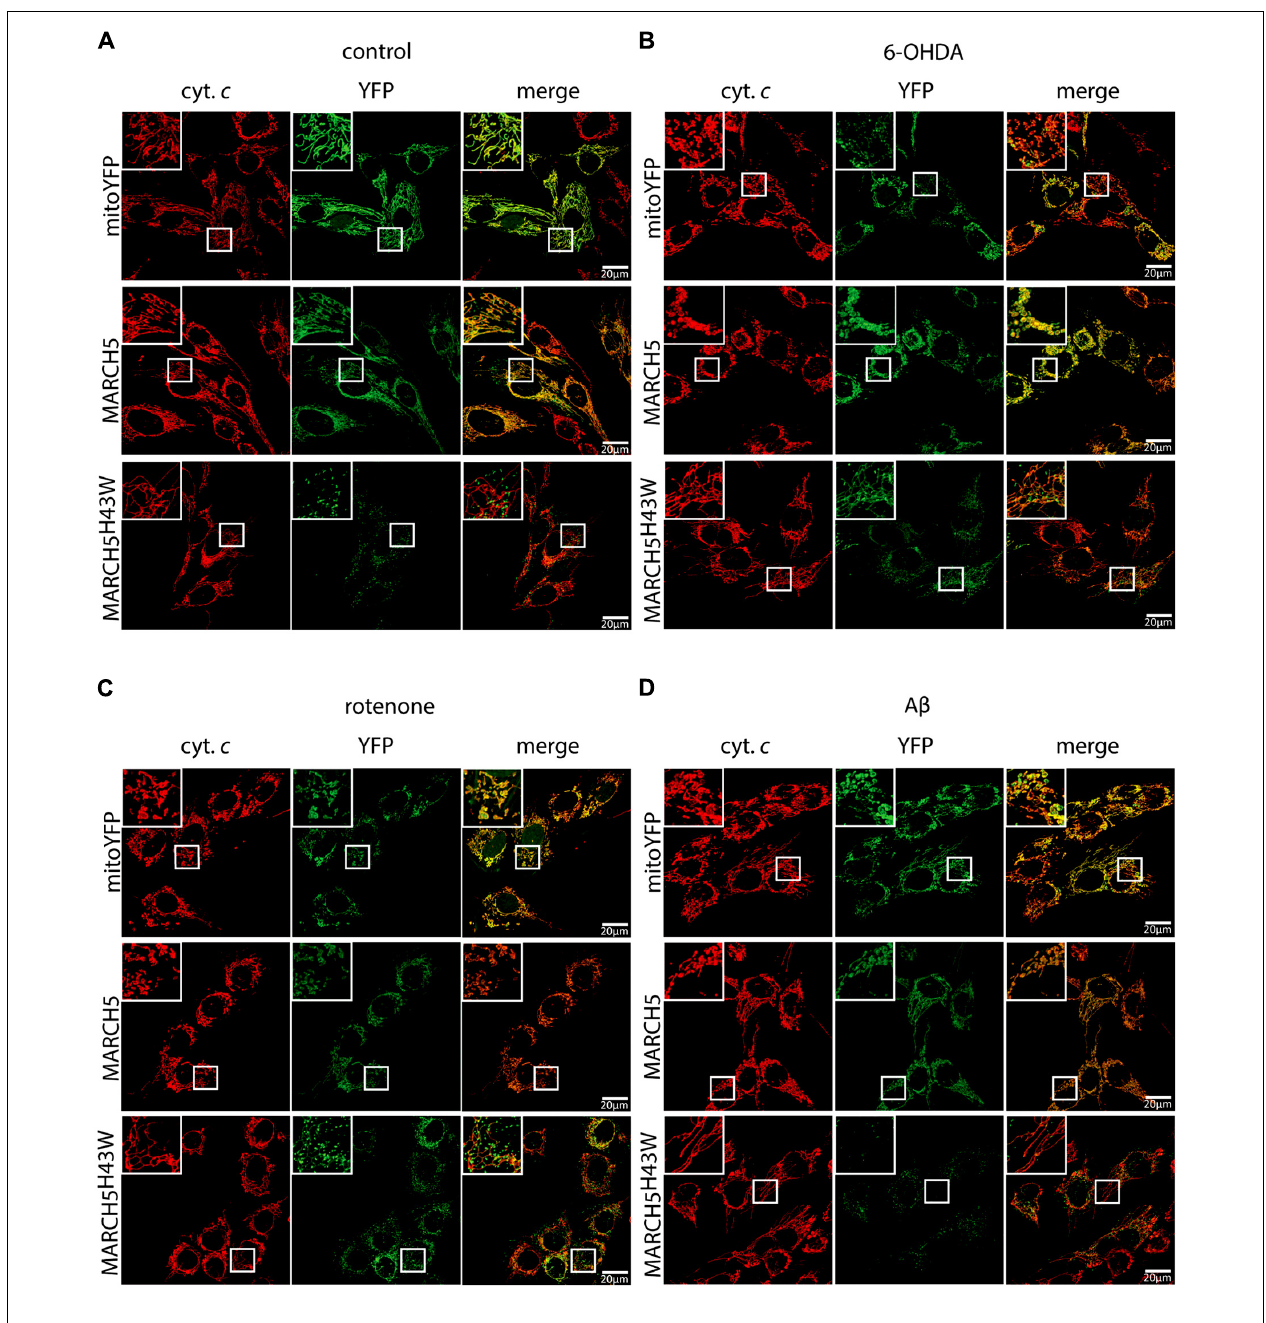
FIGURE 2 | Inactivation of MARCH5 prevents stress-induced mitochondrial fragmentation . SH-SY5Y cells selected to express mitochondria-targeted YFP (mitoYFP), MARCH5-YFP, or MARCH5 H43W -YFP mock treated (A) or treated with 75 μ M 6-hydroxydopamine for 6 h (B) ,